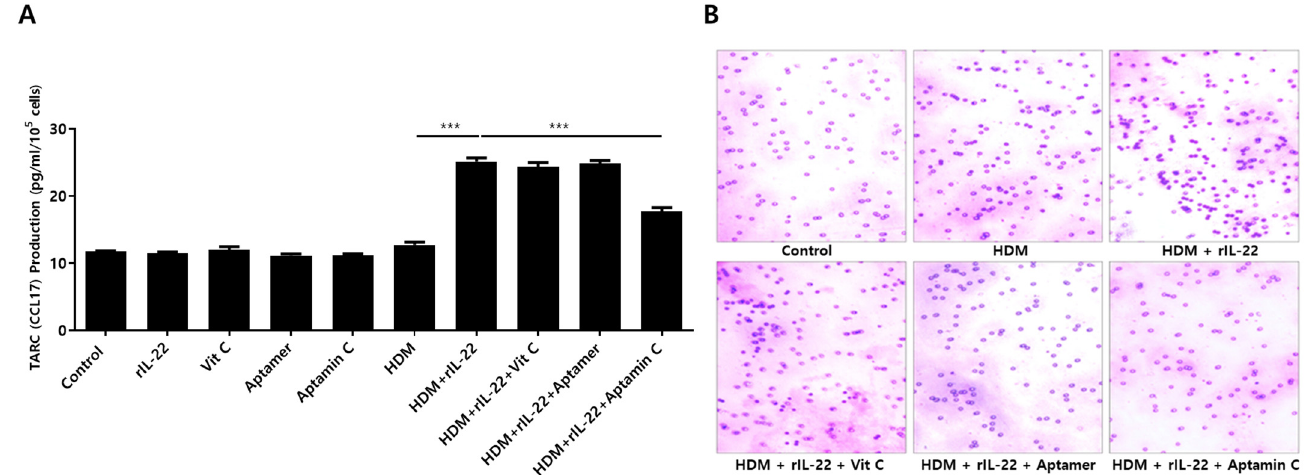
Figure 4. Effects of HDM extract on thymus and activation-regulated chemokine (TARC) production by HaCaT and on T cell migration, and suppression of these effects by Aptamin C. ( A ) Aptamin C downregulates the HDM extract-associated increase in production of TARC by HaCaT. Data are presented as the mean ± SD. *** p < 0.001. ( B ) Transwell migration assays showing Aptamin C-associated suppression of HDM extract-enhanced T cell migration over 48 or 72 h. Results are the representative of three independent experiments.